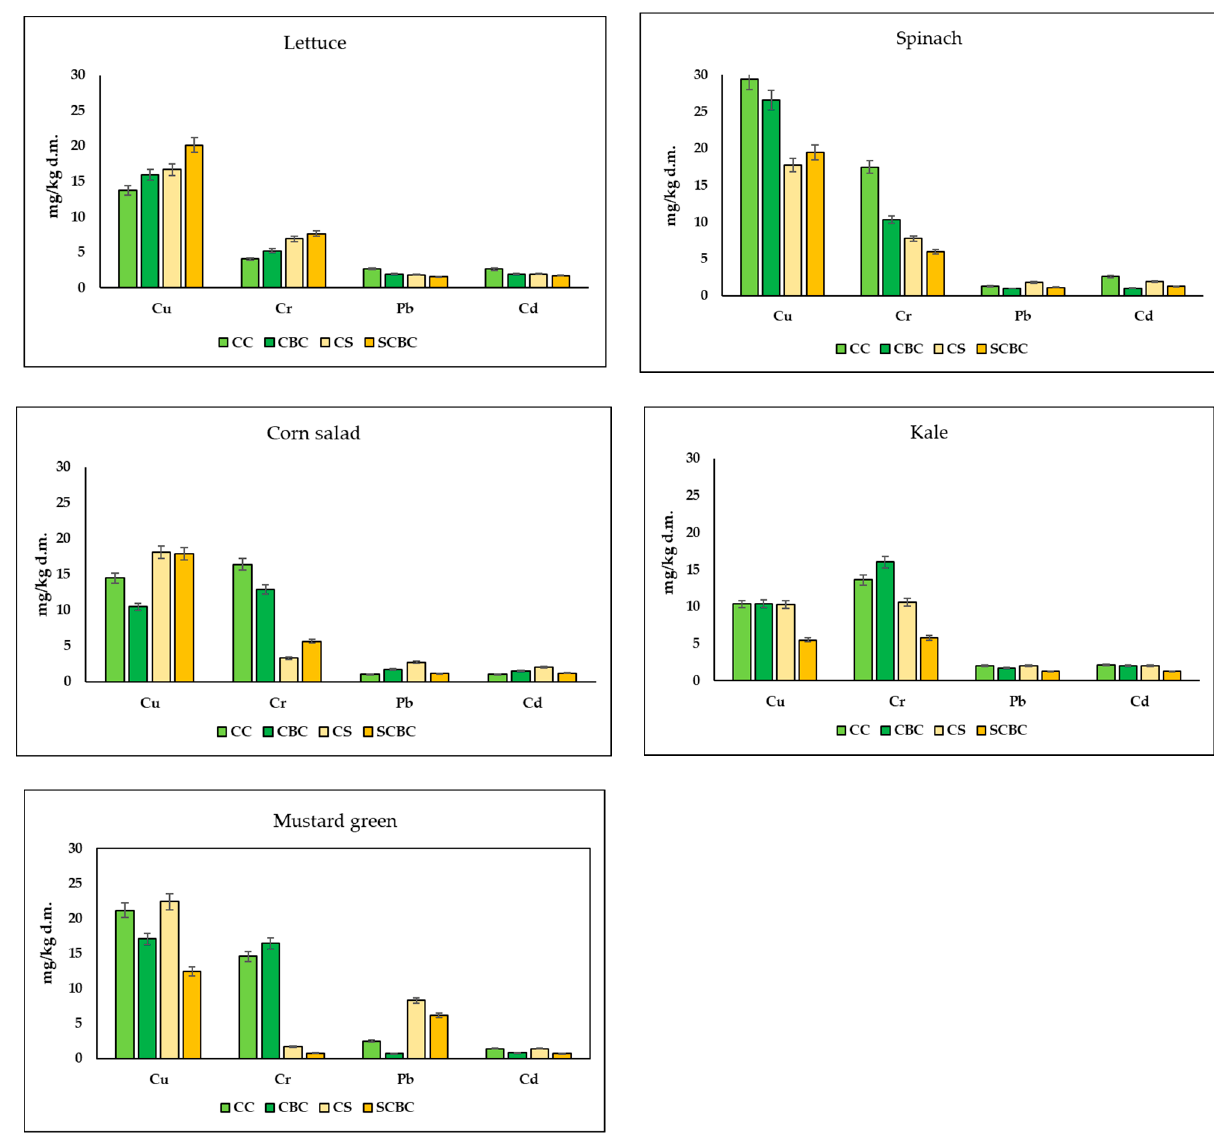
Figure 4. Concentration of Cu, Cr, Pb and Cd in plants grown without (CC—control compost and CS—control soil) and with (CBC—compost with rabbit manure biochar, SCBC—soil with mix of biochar and compost) organic amendments.